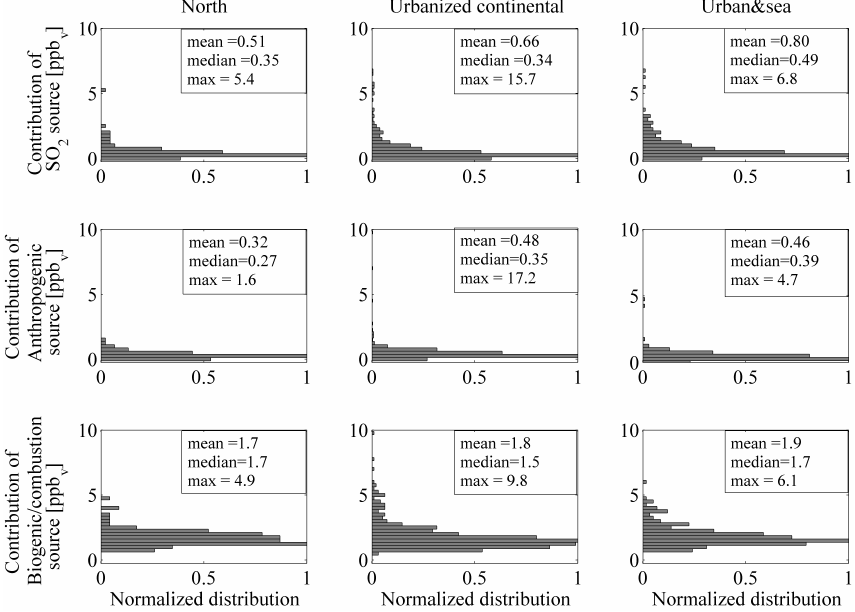
Figure 10. Normalized distributions of different sources in three sectors during the summer. The first column is the north sector ( N = 338), the second column is the urbanized continental sector ( N = 1817) and the third column is the urban and sea sector ( N = 952). In the topmost row all panels are distributions of the SO 2 source, the middle row the anthropogenic source and the lowest row biogenic/combustion source. Each sector has been normalized with the maximum value of the observations. Mean, median, and maximum values of source contributions are shown for each sector.